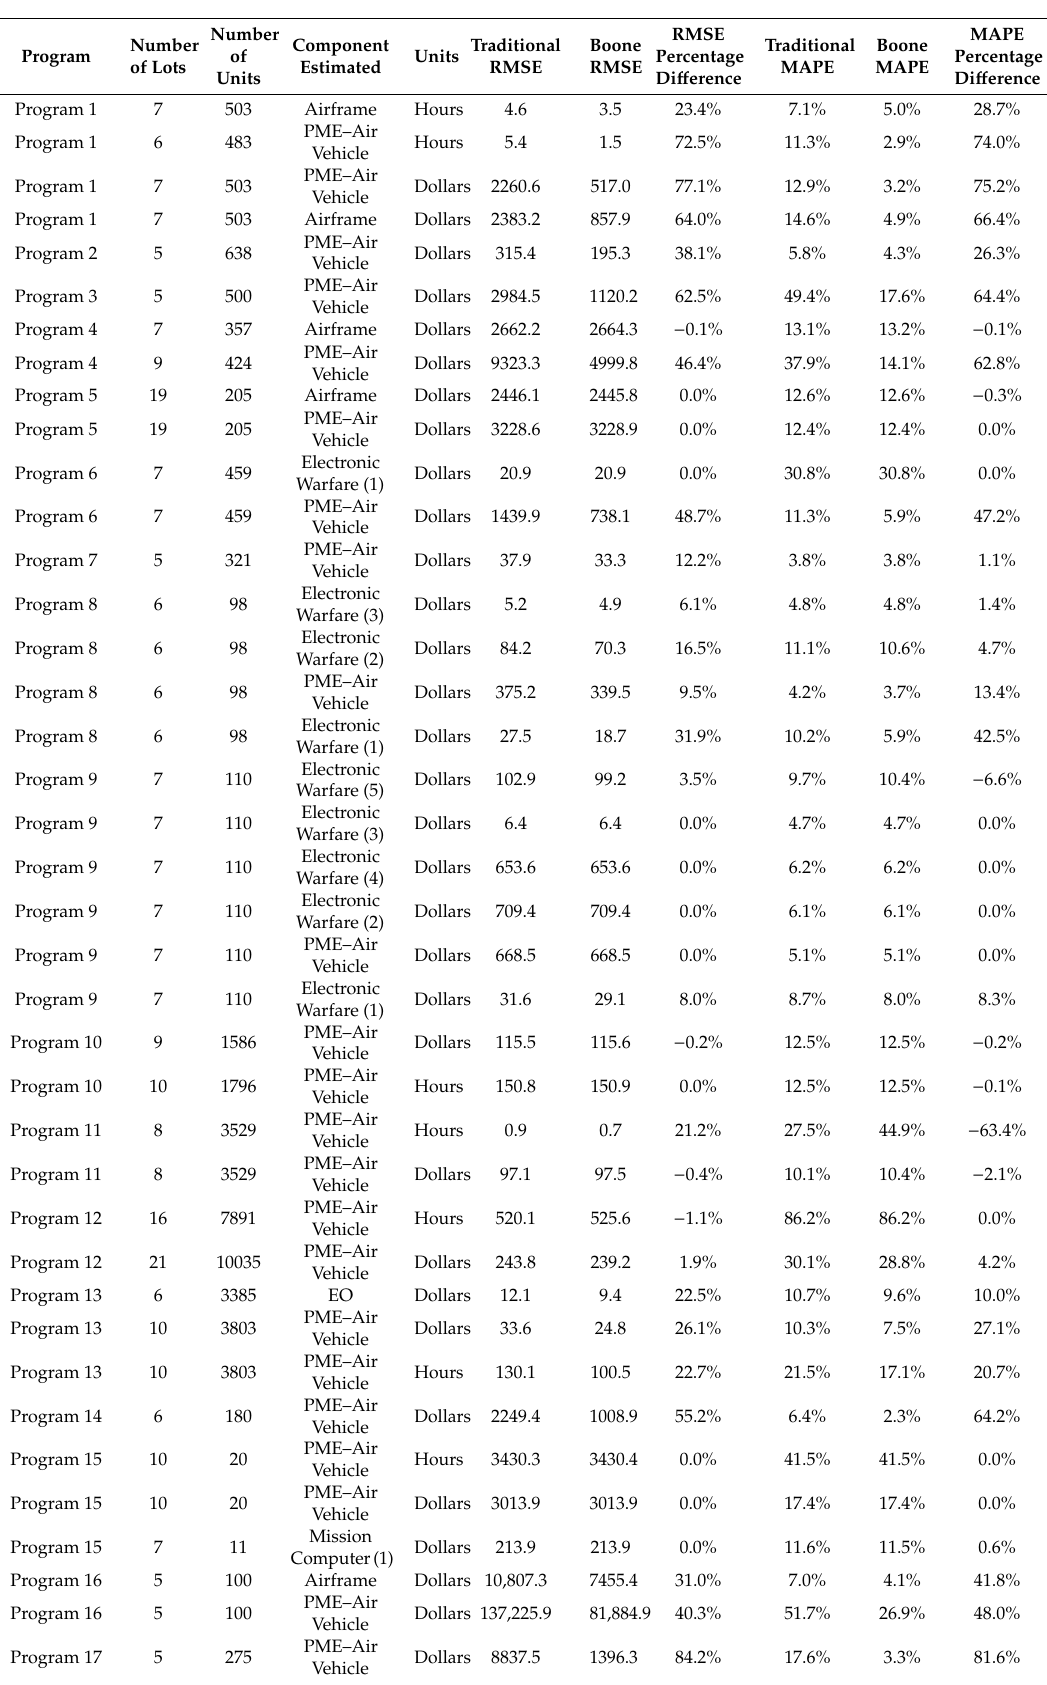
Table A2. Error Comparison using Unit